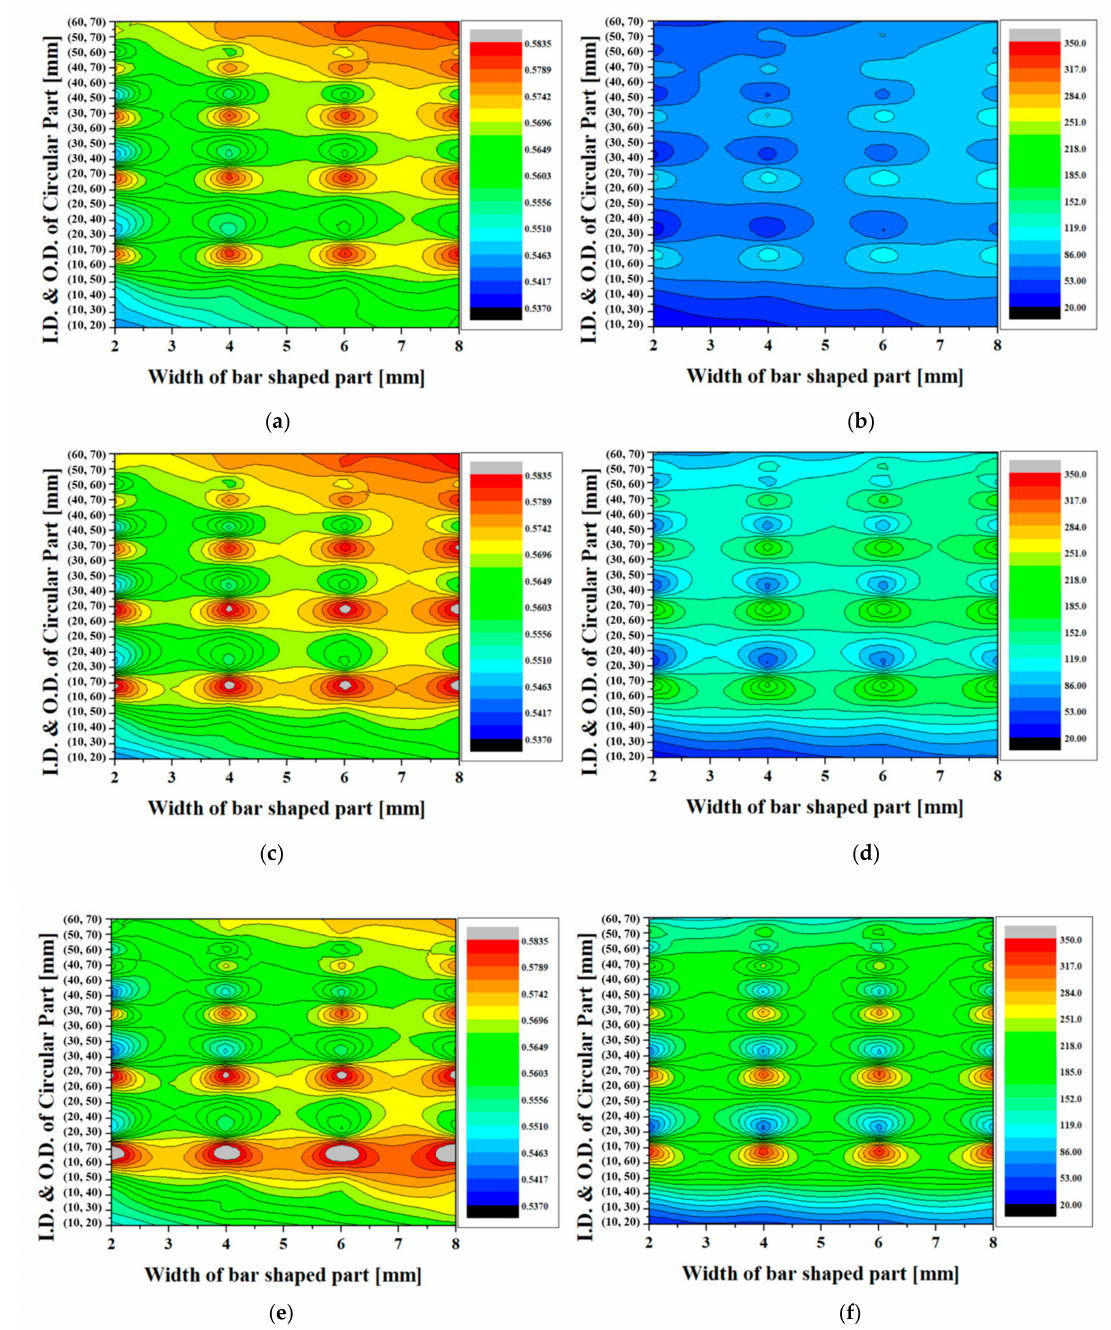
Figure 12. Coupling coe ffi cient and core weight according to the circular bar core dimensions of the T X pad: ( a ) coupling coe ffi cient at t D = 1 mm, ( b ) ferromagnetic core weight at t D = 1 mm, ( c ) coupling coe ffi cient at t D = 2 mm: ( d ) ferromagnetic core weight at t D = 2 mm, ( e ) coupling coe ffi cient at t D = 3 mm, and ( f ) ferromagnetic core weight at t D = 3